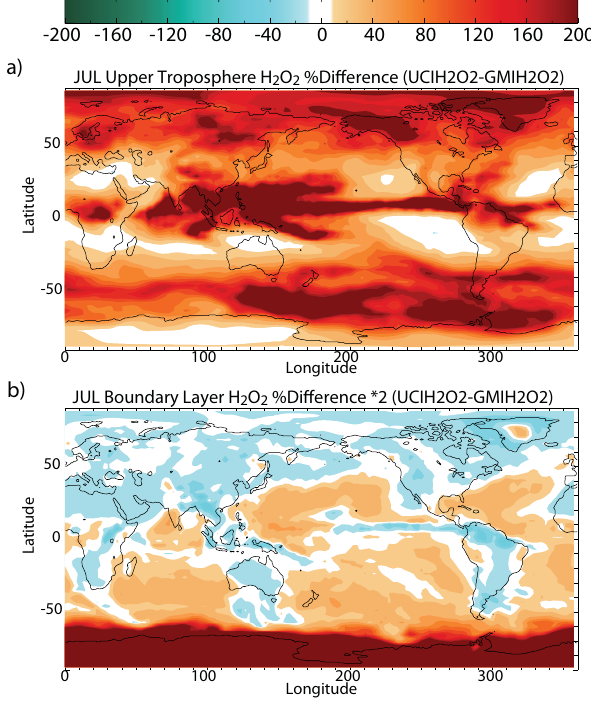
Fig. 6. (a) Latitude-longitude cross section of the percent differ- ence between UCI-H2O2 and GMI-H2O2 H 2 O 2 averaged over the upper troposphere (150hPa <p < 500hPa) for July. Contour range is − 200 to 200%. (b) Same as (a) , but H 2 O 2 is averaged over the boundary layer ( p > 850hPa) and the percent difference is multi- plied by 2 to allow use of the same contour interval.